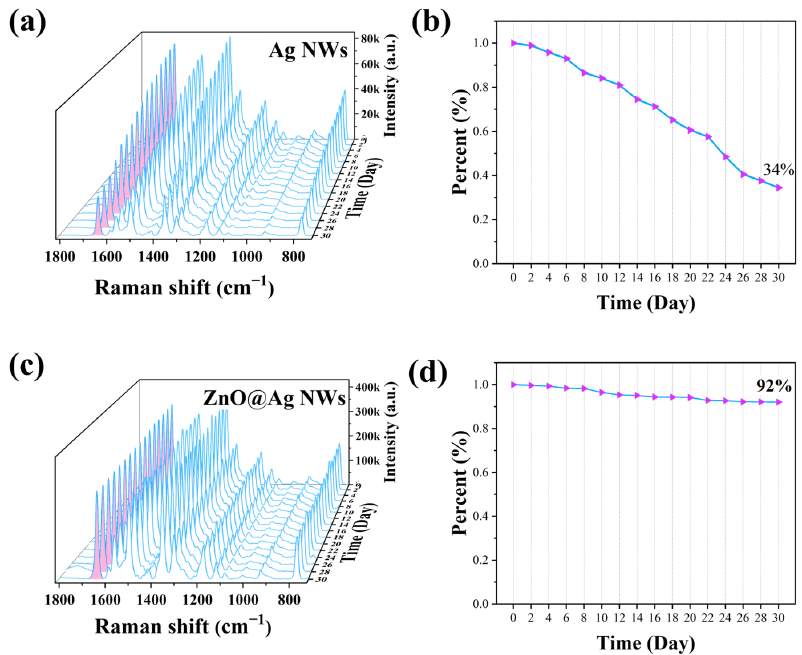
Figure 6. SERS spectra: long-term stability of 10 − 6 M R6G on Ag NWs ( a , b ) and ZnO NPs@Ag NWs ( c , d ) was measured every two days during one month at room